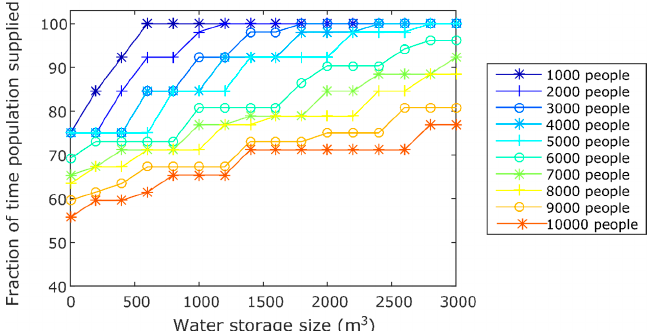
Figure 7. Number of people supplied with freshwater over one year using a water storage tank of 2800 m 3 .